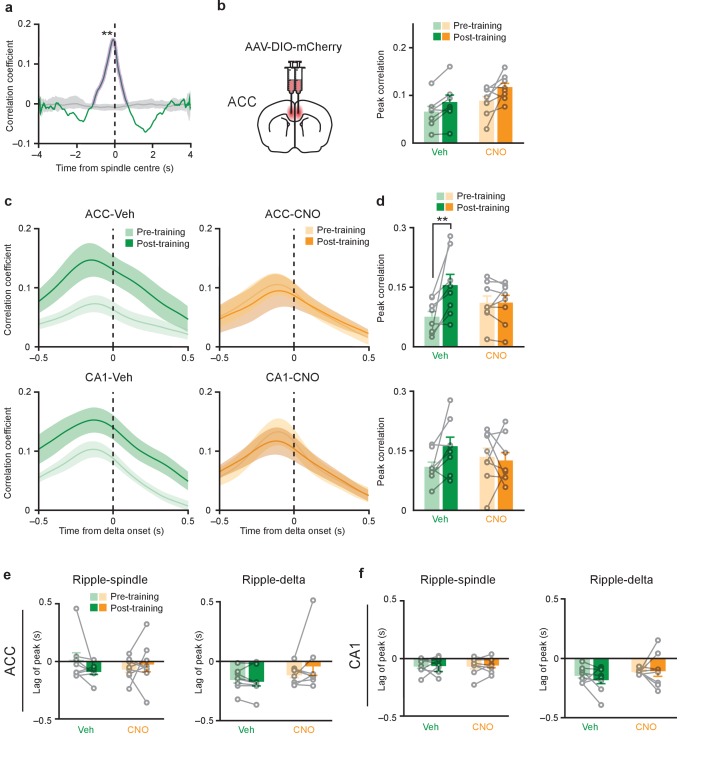
Probability of ripple-spindle coupling is significantly greater than chance; and learning-induced increase in ripple-spindle coupling is not prevented by CNO in mice infused with the control virus; similar to the effect on ripple-spindle coupling, inhibition of PV+cell in the ACC or CA1 eliminates learning-induced increases in ripple-delta coupling, without changing the time lag between baseline ripple and spindle or delta oscillations.(a) A representative example of original vs. shuffled correlation in one mouse infused with AAV-DIO-hM4Di-mCherry in CA1 and recorded during the Pre-training session, showing that ripple-spindle coupling at baseline was significantly higher than chance (grey shaded line/region: shuffled correlation mean, and 1st/99th percentile of 100 shuffles; green line: original correlation; purple shaded region: statistically significant original versus shuffled correlation, permutation test, 100 permutations, p=0.01). (b) Ripple-spindle coupling was assessed in mice infused with AAV-DIO-mCherry virus in ACC. In these mice, learning-induced increases in cross-correlation between ripple and spindle amplitude were observed in both Veh- and CNO-treated groups (peak cross-correlation coefficients: DMSO n = 7, CNO n = 8; two-way repeated measures ANOVA pre-training versus post-training x Veh versus CNO; pre-training versus post-training F1,13 = 12.2, p=0.004; Veh versus CNO F1,13 = 2.98, p=0.11; interaction F1,13 = 0.34, p=0.57). (c) Learning-induced increases in cross-correlation between delta and ripple amplitude in Veh-treated mice were prevented in mice micro-infused with hM4Di-mCherry in ACC or CA1 by CNO treatment. (d) Peak cross-correlation coefficients quantified from (a), in mice micro-infused with virus in ACC (top; n = 8 per group; two-way repeated measures ANOVA pre-training versus post-training x Veh versus CNO; pre-training versus post-training F1,14 = 7.80, p=0.014; Veh versus CNO F1,14 = 0.03, p=0.86; interaction F1,14 = 7.52, p=0.016; post hoc Bonferroni’s test, Veh pre-training versus Veh post-training p=0.003, CNO pre-training versus CNO post-training p>0.99), or CA1 (bottom; n = 8 per group; two-way repeated measures ANOVA pre-training versus post-training x Veh versus CNO; pre-training versus post-training F1,14 = 1.52, p=0.24; Veh versus CNO F1,14 = 0.05, p=0.83; interaction F1,14 = 3.08, p=0.10). (c) No change in lag between ripples and spindles in Veh- or CNO-treated mice micro-infused with virus in ACC (top; n = 8 per group; Mann-Whitney test p=0.48; Wilcoxon signed-rank test Veh pre-training versus post-training p=0.20, CNO pre-training versus post-training p=0.64), or CA1 (bottom; n = 8 per group; two-way repeated measures ANOVA pre-training versus post-training x Veh versus CNO; pre-training versus post-training F1,14 = 0.14, p=0.71; Veh versus CNO F1,14 = 0.03, p=0.87; interaction F1,14 = 0.02, p=0.88). (e) No change in lag between ripple and delta oscillations, in mice micro-infused with virus in ACC (top; n = 8 per group; Mann-Whitney test p=0.39, Wilcoxon signed-rank test Veh pre-training versus post-training p=0.69, CNO pre-training versus post-training p=0.64), or (f) CA1 (bottom; n = 8 per group; two-way repeated measures ANOVA pre-training versus post-training x Veh versus CNO; pre-training versus post-training F1,14 = 0.49, p=0.50; Veh versus CNO F1,14 = 0.39, p=0.54; interaction F1,14 = 0.06, p=0.80).